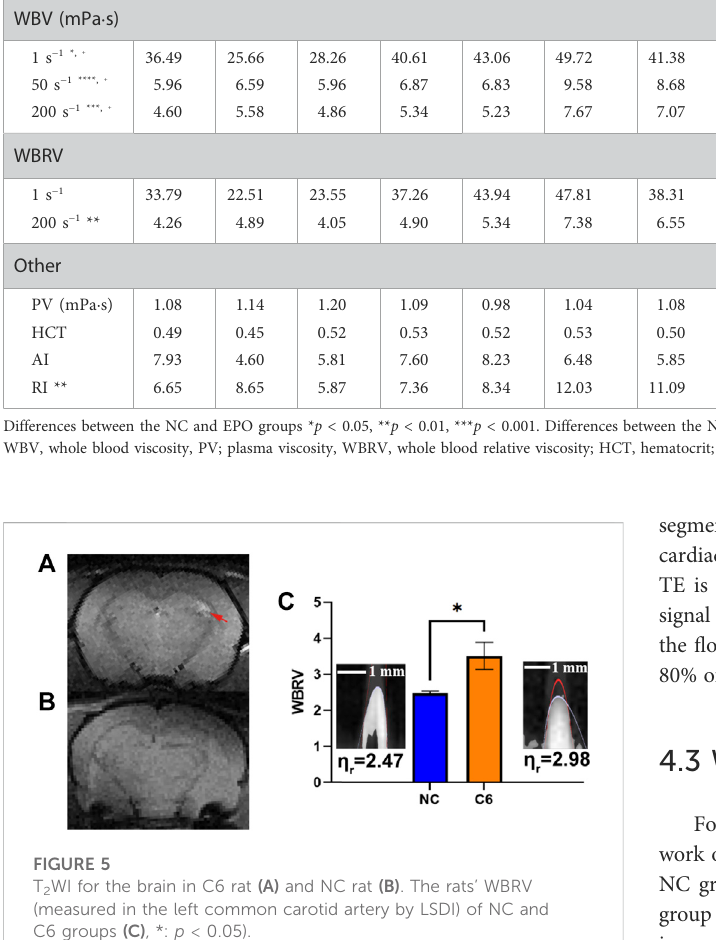
TABLE 1 Results of hemorheological tests. Rat no.